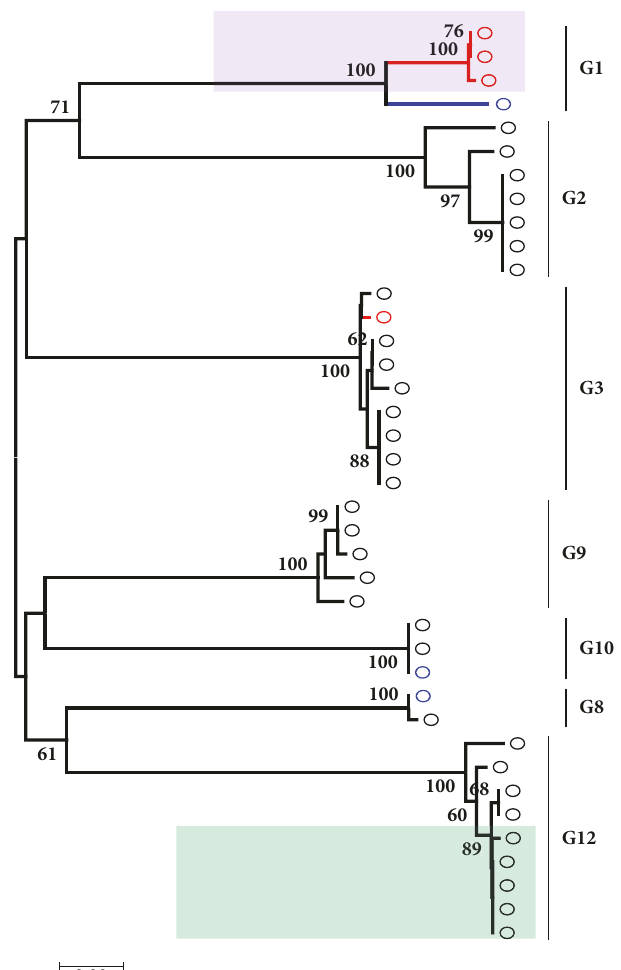
Figure 1: Phylogenetic analysis of the partial VP7 (G) gene sequence of Nigerian rotavirus strains from 1994 to 2015. Environmental isolates recovered from sewage effluent are shown in red; clinical isolates submitted to Genbank before the year 2000 are shown in blue. Genotype assignments are indicated by the side of the horizontal bars in the tree. The light purple shaded region shows isolates belonging to lineage II genotype G1, while the light green shaded region shows isolates belonging to lineage III genotype G12. The phylogenetic tree was constructed using neighbor joining algorithm in MEGA 6.0 with 1000 bootstrap replicates. The scale bar indicates number of substitutions per